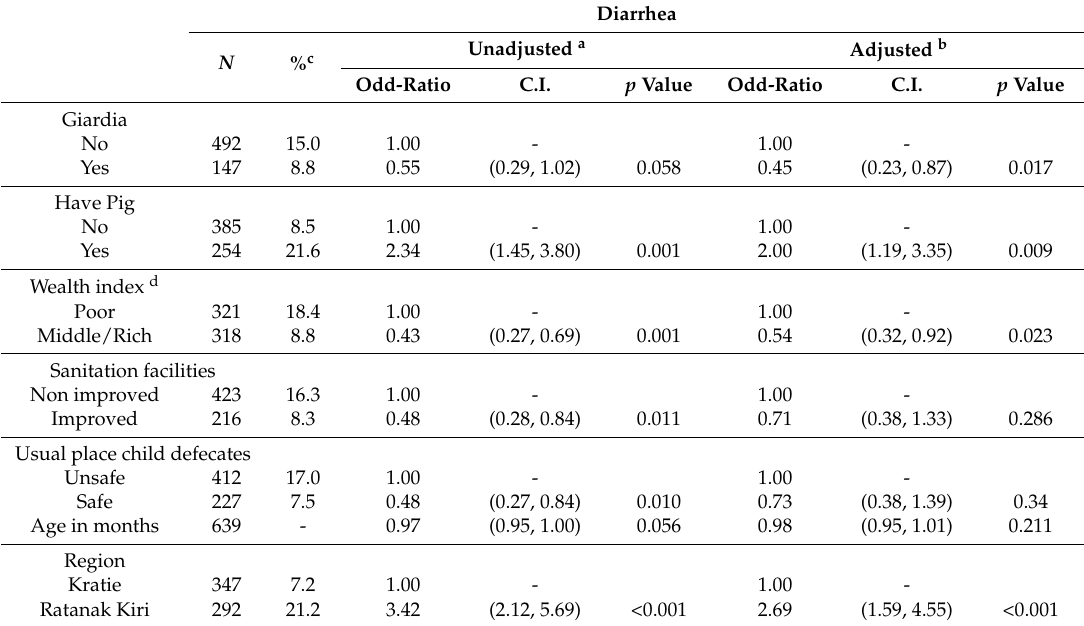
Table 3. Logistic regression model for the association between acute diarrhea and selected covariates.